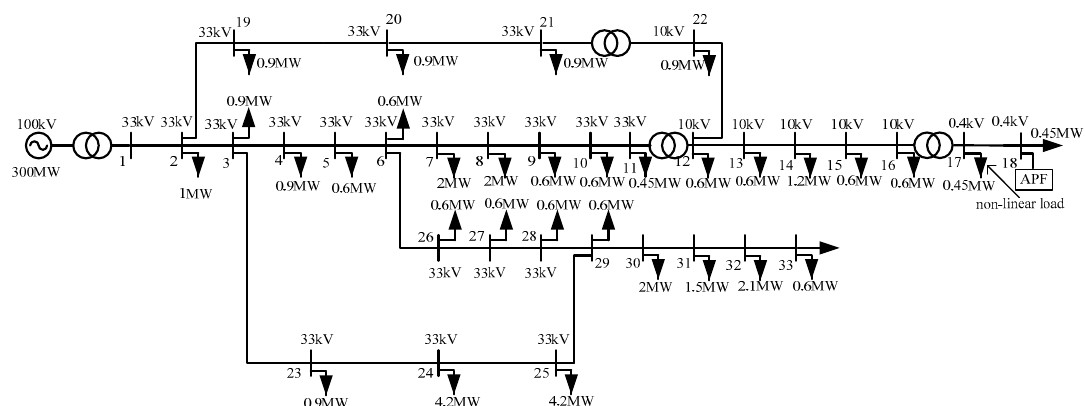
Figure 14. The IEEE-33 bus distribution system.